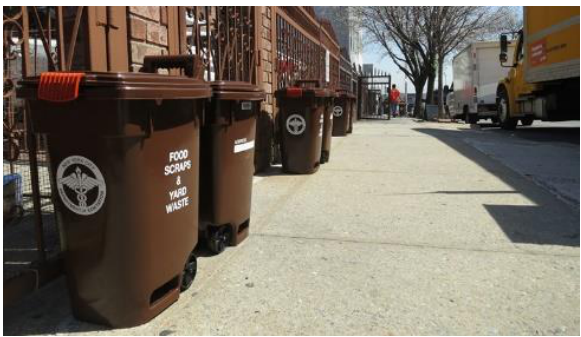
Figure 3. Bins for food scraps and other organics in New York [95].